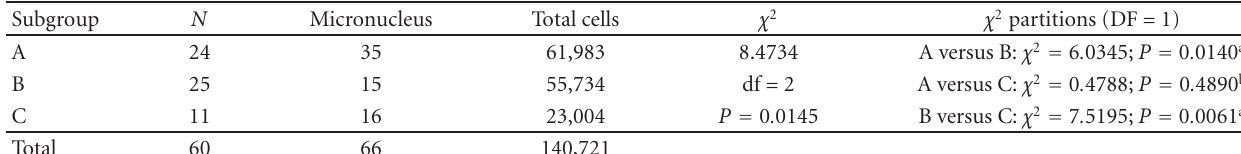
Table 3: Data relating to micronucleus occurrence in smokers (A), nonsmokers and nondrinkers (B), and smokers and drinkers